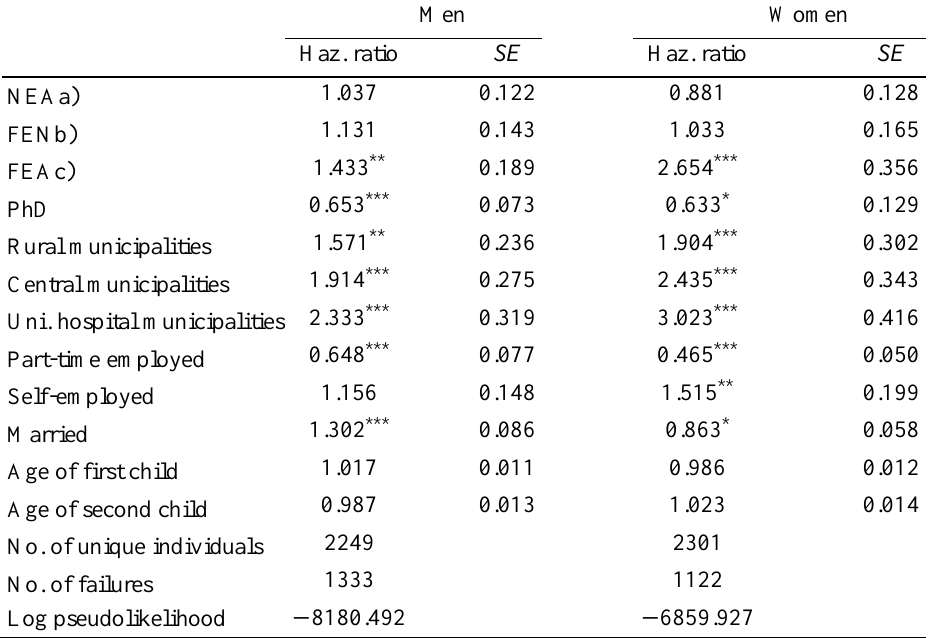
Cox proportional hazards